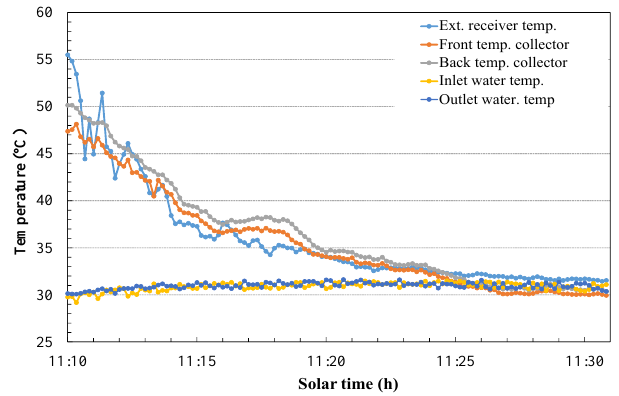
Figure 18. Variation of the temperature as a function of time with- out activation of the tracking system.